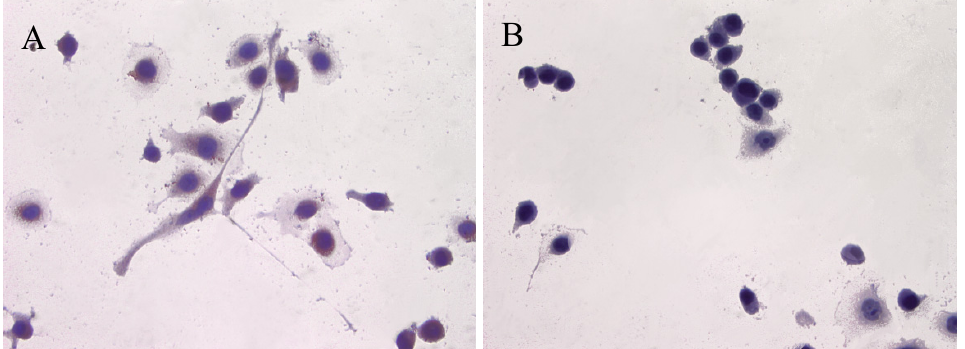
Figure 2. Immunolocalization of ATIP in PC3 cells ( A and C ) with haematoxylin counter- stain ( A ) and without counter-stain ( C ); ( B and D ) serial cover slips pre-absorbed with ATIP antigen with ( B ) and without ( D ) haematoxylin counter-stain respectively. Images were taken at 400×